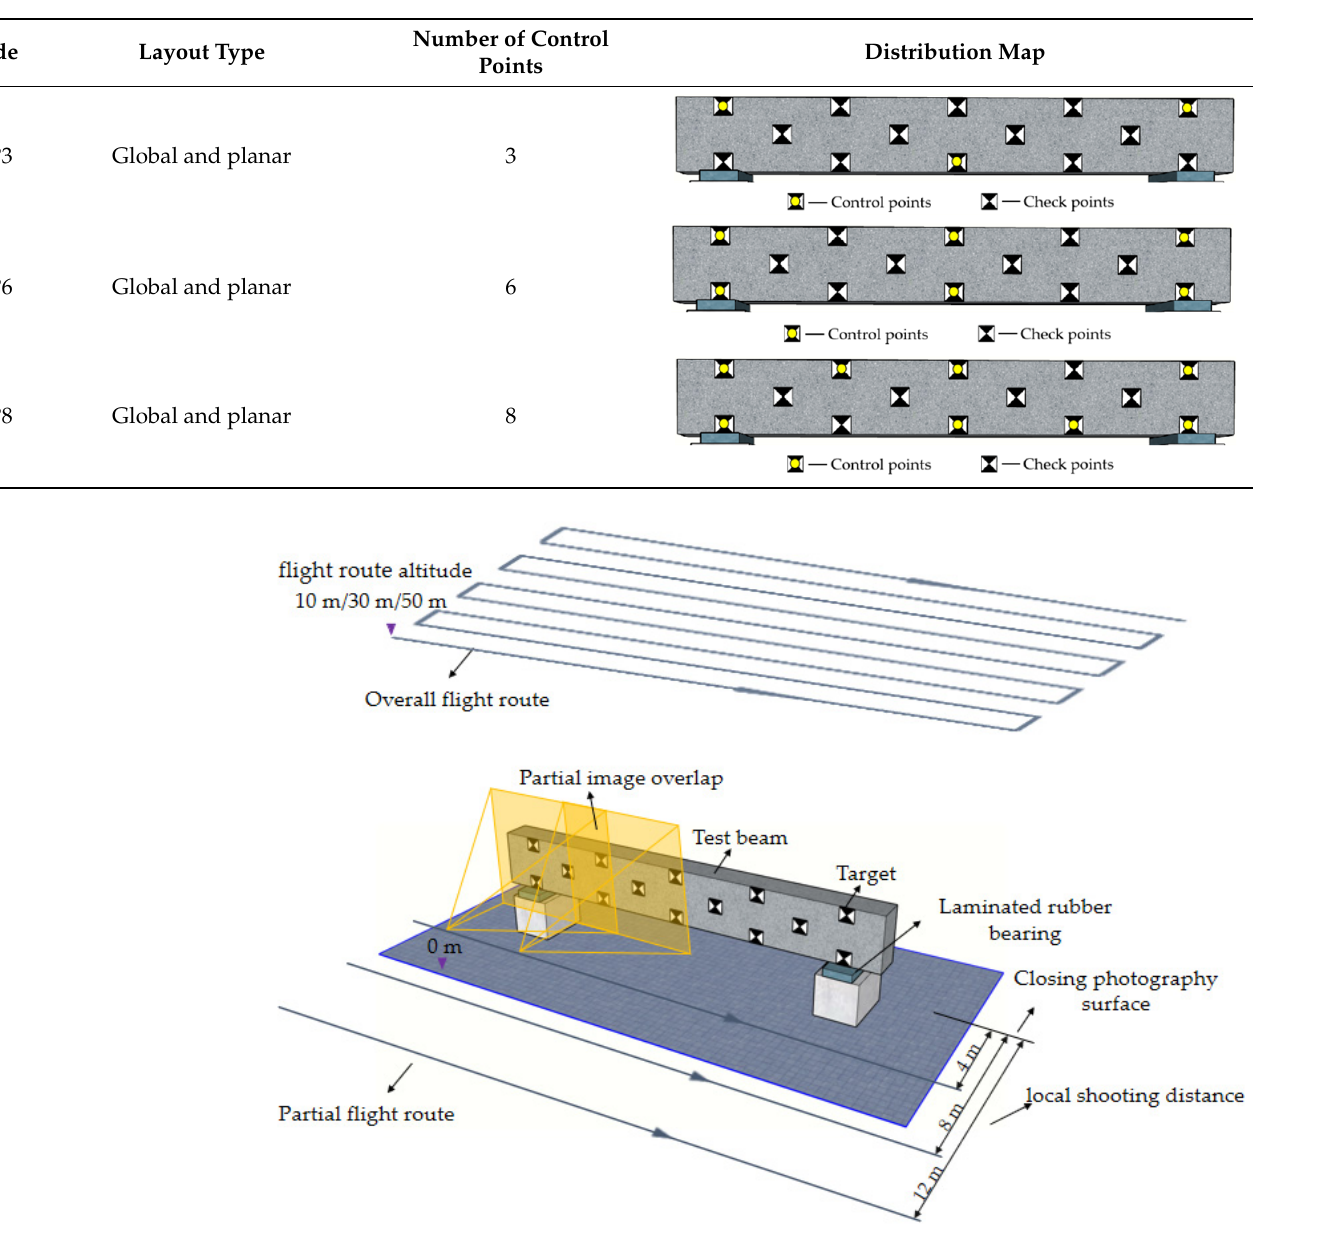
Figure 5. Schematic diagram of testing parameters.